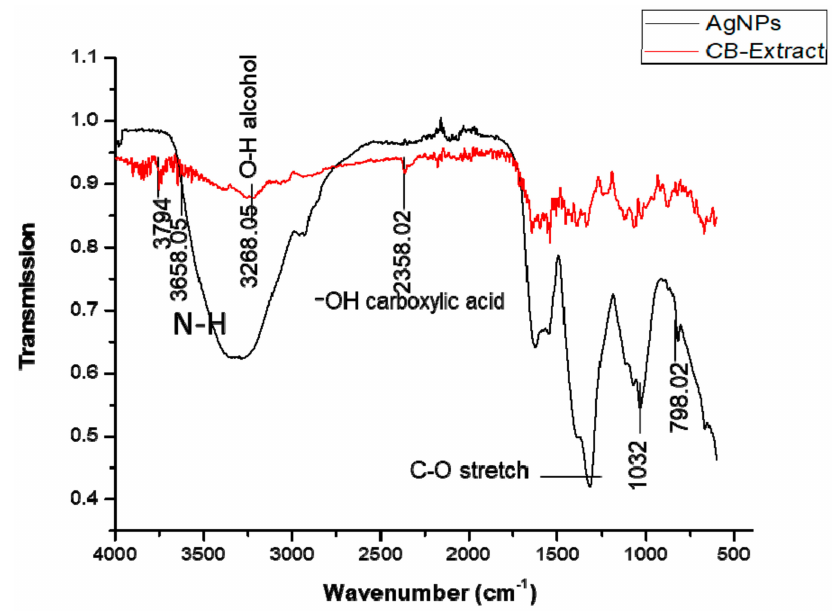
Figure 4. FTIR spectrum of biogenically synthesized silver nanoparticles with extract.